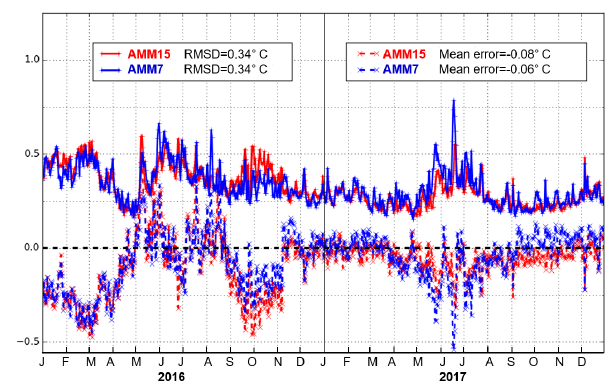
Figure 9. OSTIA minus model SST RMSD and bias daily com- parison for AMM7 (blue) and AMM15 (red) for the whole domain (negative mean error indicates a warm model